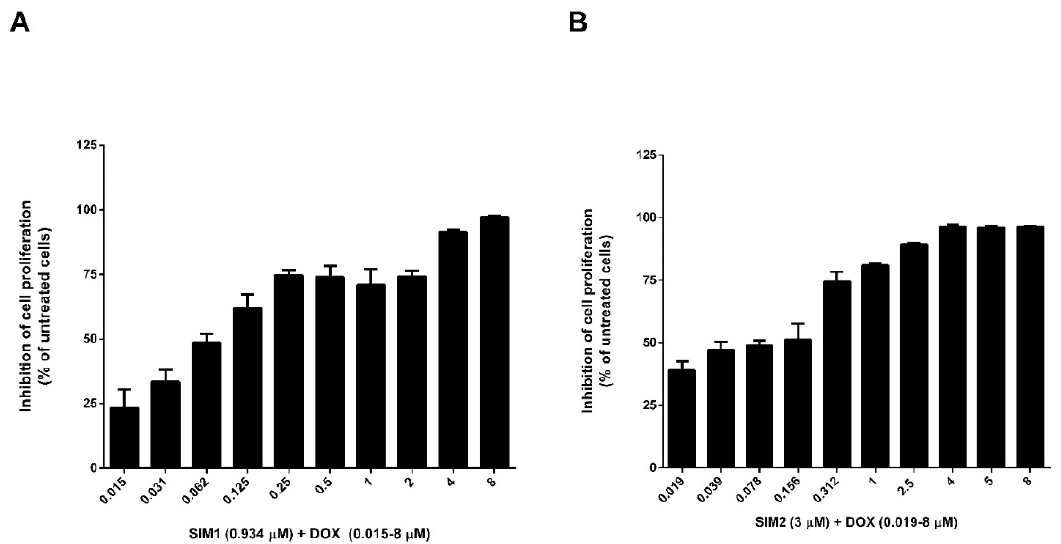
Figure 10. The effects of combined treatment with free SIM and DOX on the proliferation of C26 murine colon carcinoma cells co-cultured with murine macrophages. The results show cell proliferation at 48 h after incubation of C26 murine colon carcinoma cells and murine macrophages with: ( A ) 0.934 µM SIM1 with DOX solutions of variable concentrations (0.015–8 µM DOX) or ( B ), 3 µM SIM2 with DOX solutions of variable concentrations (0.019–8 µM DOX). Data are presented as the mean ± standard deviation of triplicate measurements. The results are expressed as percentage of inhibition of co-cultured cells proliferation following SIM and DOX treatments, compared to the proliferation of control cells (untreated cells). Significance was considered at values of p < 0.05 (ns, p > 0.05; * p < 0.05; ** p < 0.01; *** p < 0.001; **** p < 0.0001).